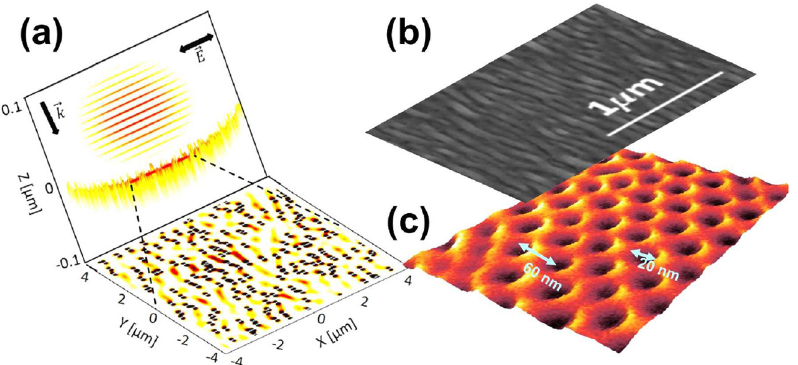
Figure 7: (a) Conceptual illustration of light and material patterns. (b) High-frequency spatial structures (HSFL) with sub-100-nm periodicities. Reprinted with permission from a study by Nathala et al. [23] ©Springer-Nature. (c) Nanohole pattern